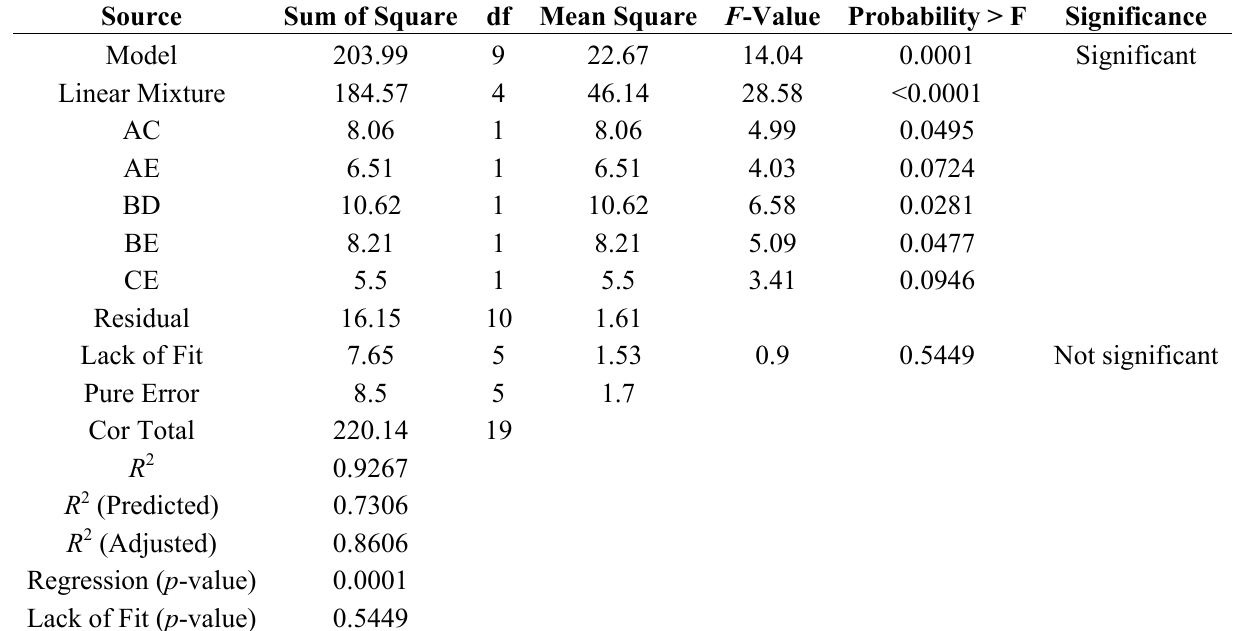
Table 2. Analysis of variance (ANOVA) for the D-optimal mixture design of the quadratic model. Source